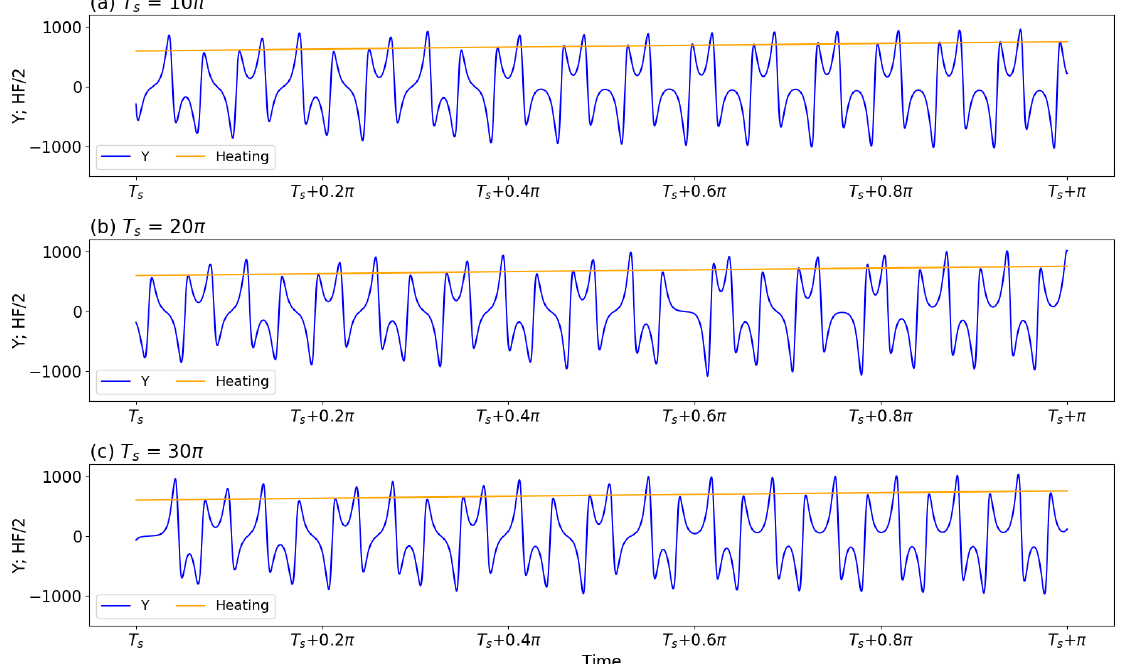
The green, blue, and red lines represent the solutions of the control and two parallel runs. The parallel runs include an initial tiny perturbation, (cid:101) = 10 − 8 or (cid:101) = − 10 − 8 . The heating function is indicated by an orange line. From top to bottom, panels ( a , b ) display the three orbits and the heating parameters for τ ∈ [0, 35 π ], respectively. Panel ( c ) for τ ∈ [19, 21] displays diverged trajectories, showing SDIC. The first kind of attractor coexistence (i.e., coexisting chaotic and steady-state solutions) is shown in panel ( d ) for τ ∈ [29, 31]. The green line, indeed, represents a steady state solution. The second kind of attractor coexistence (i.e., coexisting regular oscillations and steady-state solutions) is shown in panel ( e ) for τ ∈ [39, 41]. Panel ( f ) displays a nearly steady-state solution (2Y/3) and the heating function for τ ∈ [30, 110]. The three vertical lines in panel ( b ) indicate the starting time for the analysis in Figure 6. (After Shen et al., 2021 [9]).